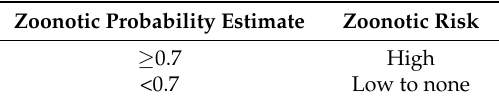
Table 2. Proposed zoonotic risk interpretation table based on zoonotic probability estimates predicted by the zoonotic strain prediction